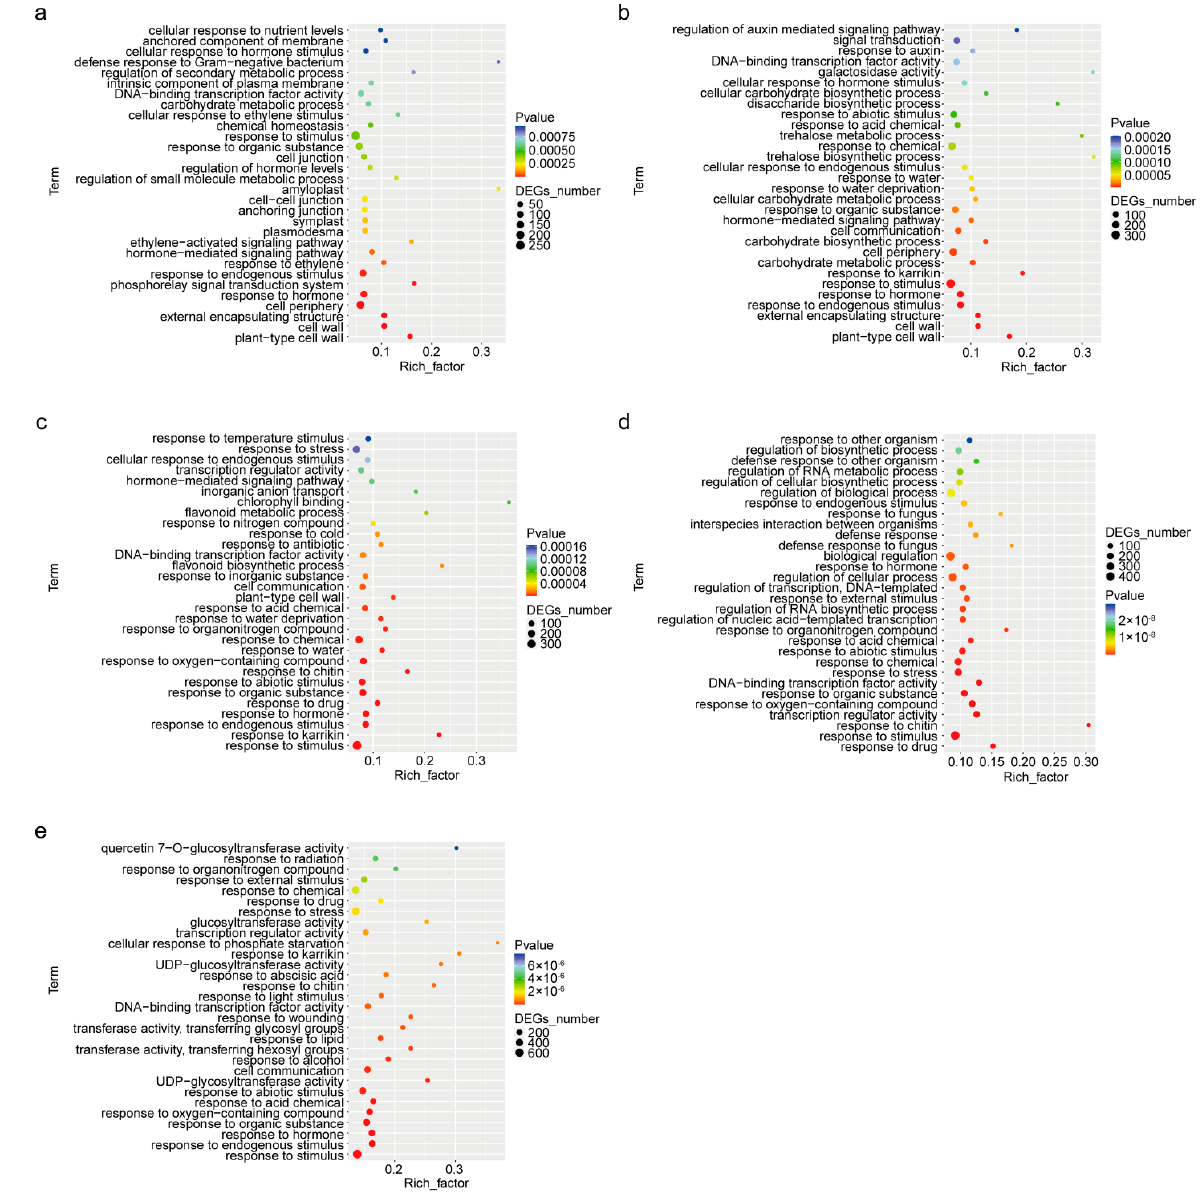
Figure 3. GO enrichment map of cold-induced DEGs. ( a ) 3 h vs. CK (0 h); ( b ) 6 h vs. CK; ( c ) 9 h vs. CK; ( d ) 12 h vs. CK; and ( e ) 24 h vs. CK. The horizontal axis represents the enrichment factor, and the ratio of differential genes enriched to a GO term to the number of background genes obtained by sequencing is presented. The vertical axis represents the enriched function of the GO term: the larger the circle, the more enriched. The number of differential genes for this function is relatively greater. The color spectrum from blue to red represents uncorrected p -values.